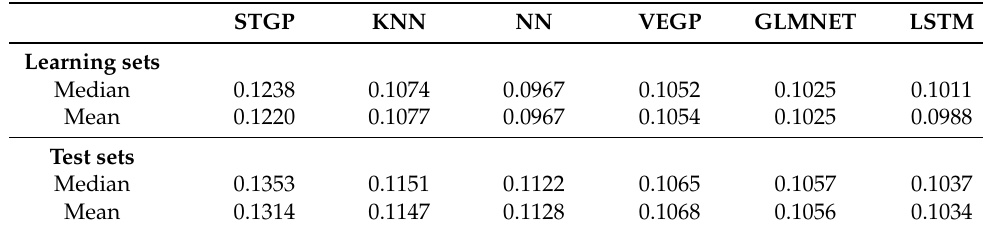
Table 9. Median and mean RMSE of the different techniques among the learning and test sets.